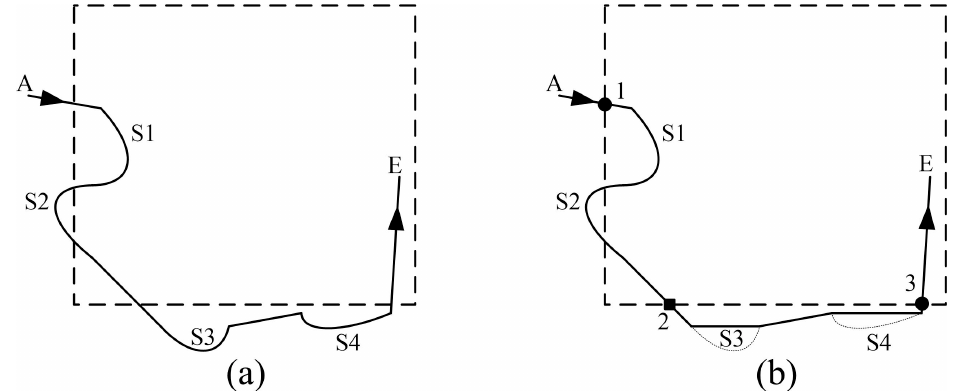
Figure 9. Schematic diagram of the clipping of the path consisting of several linear segments: ( a ) path “A-S1-S2-S3-S4-E”consists of linear segments and cubic Bezier curve units; ( b ) reserved